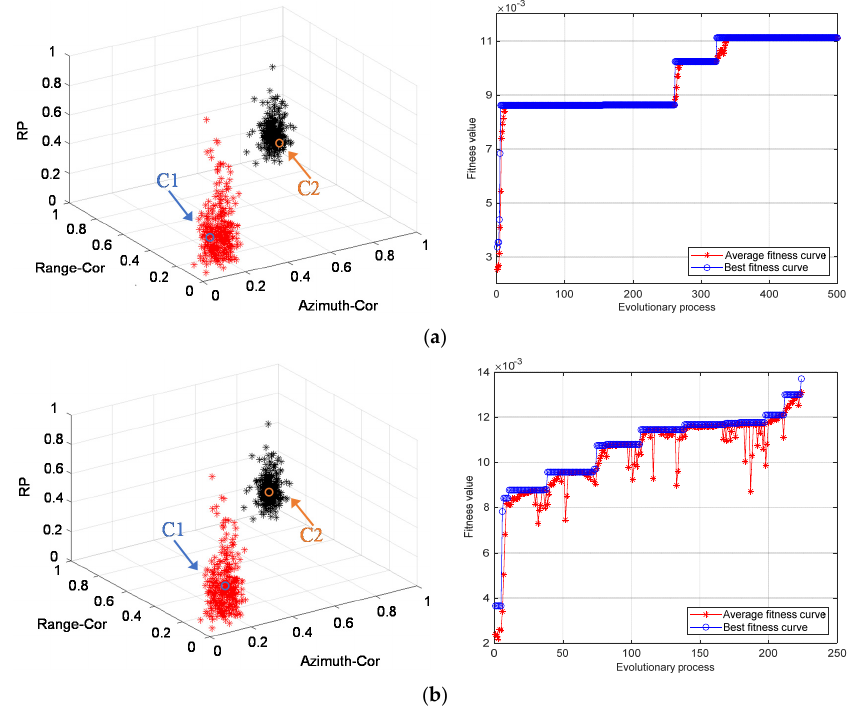
Figure 9. Clustering results of SGA ( a ) and chaotic SGA ( b ) in two-beam control modes. The population size is set to 15, and the maximum number of iterations is set to 500. The termination condition of the minimum criterion function value is 75. Note. The variables represented by the axis in the figure are dimensionless.